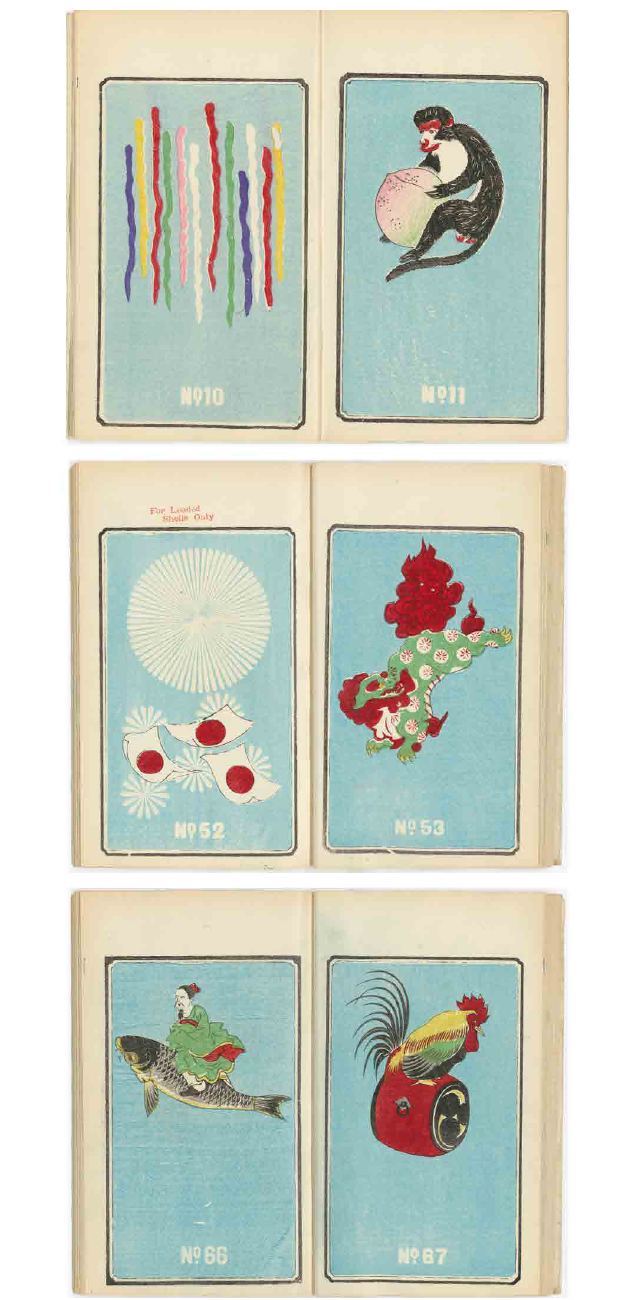
Fig. 9 Hirayama Fireworks,